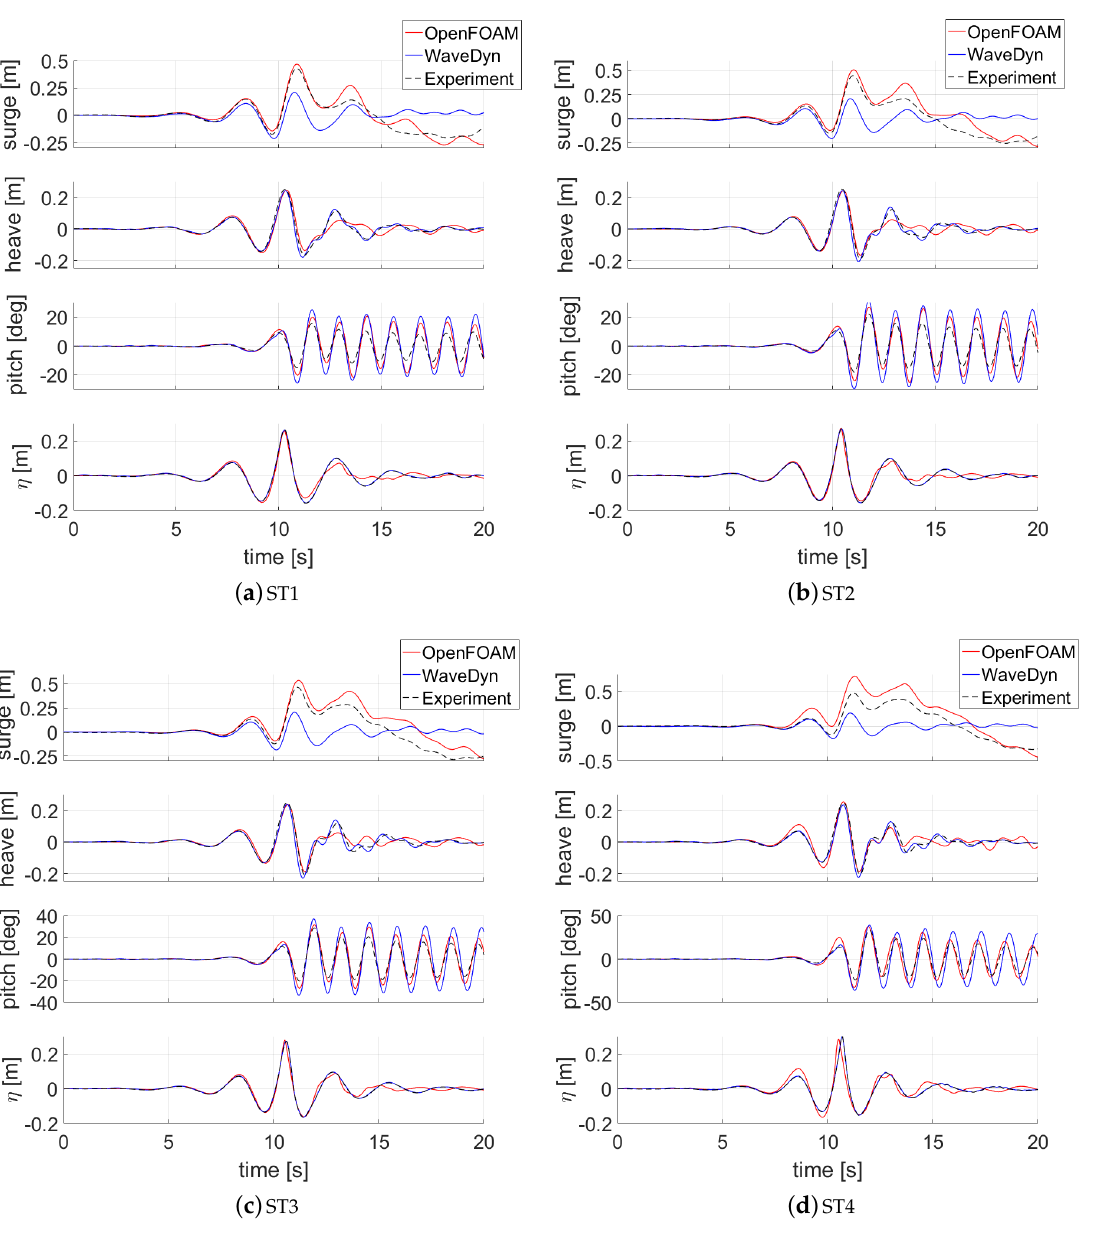
Figure 7. Surface-elevation and motion responses time-series of the X-MED buoy under ST